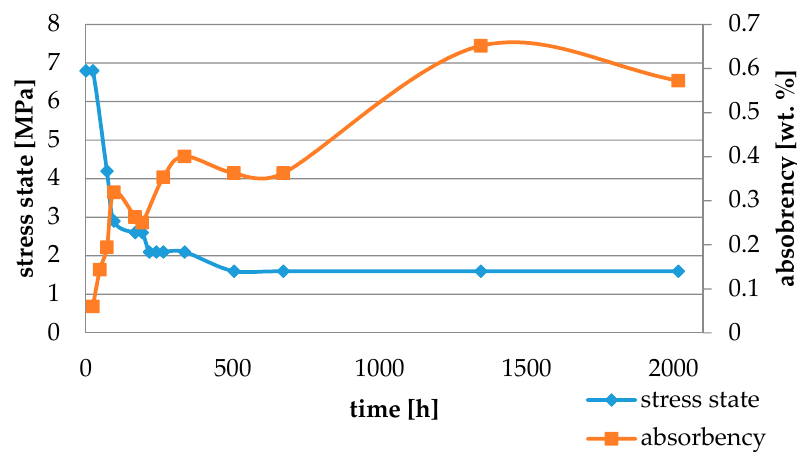
Figure 5. The influence of water sorption (2016 h water ageing) on the absorbency and contraction stress generated during the photopolymerization of Estecem. Materials 2018 , 11 , x FOR PEER REVIEW